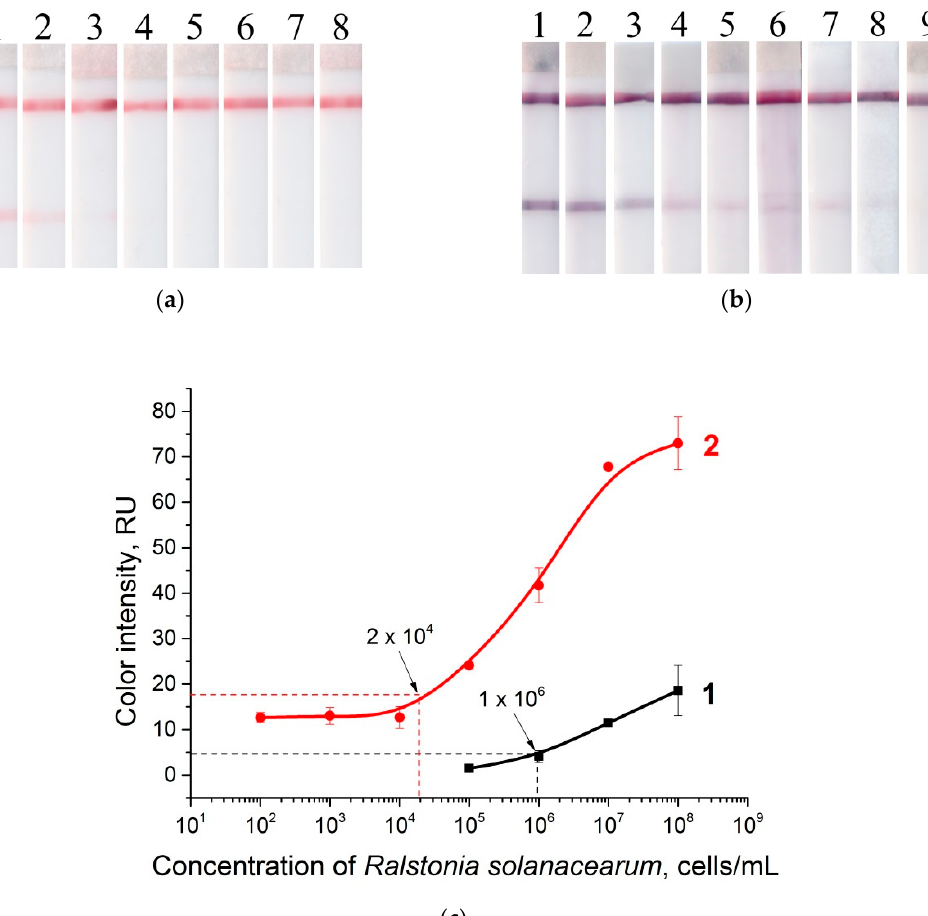
Figure 6. LFIA in buffer: ( a ) strips after testing and before enlargement; ( b ) strips after testing and enlargement. Strips #1–8 correspond to 10 8 , 10 7 , 10 6 , 10 5 , 10 4 , 10 3 , 10 2 , and 10 1 cells · mL − 1 of R. solanacearum , respectively; strip #9 corresponds to a negative control (0 cells · mL − 1 ); ( c ) calibration curves of LFIA of R. solanacearum before (1) and after (2) enlargement.